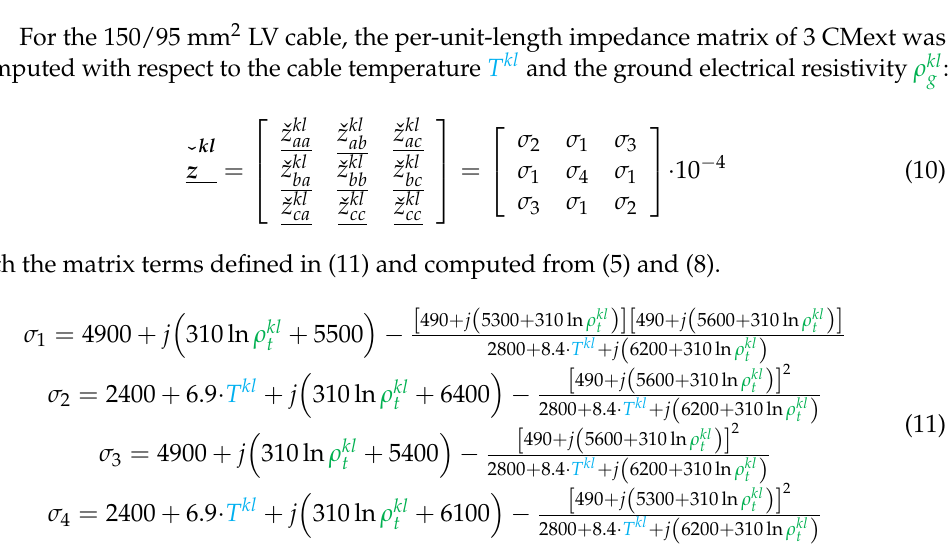
Figure 4. 3 CMext of LV cable.